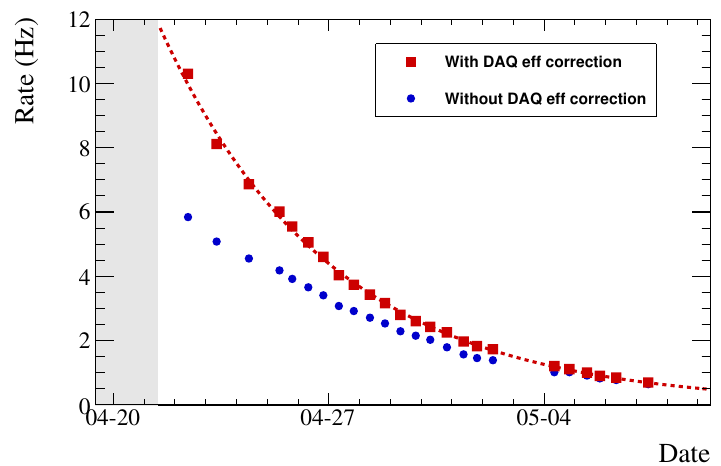
Figure 4 . Radon decay evolution during period A2, with and without DAQ e(cid:14)ciency correction. An exponential (cid:12)t is